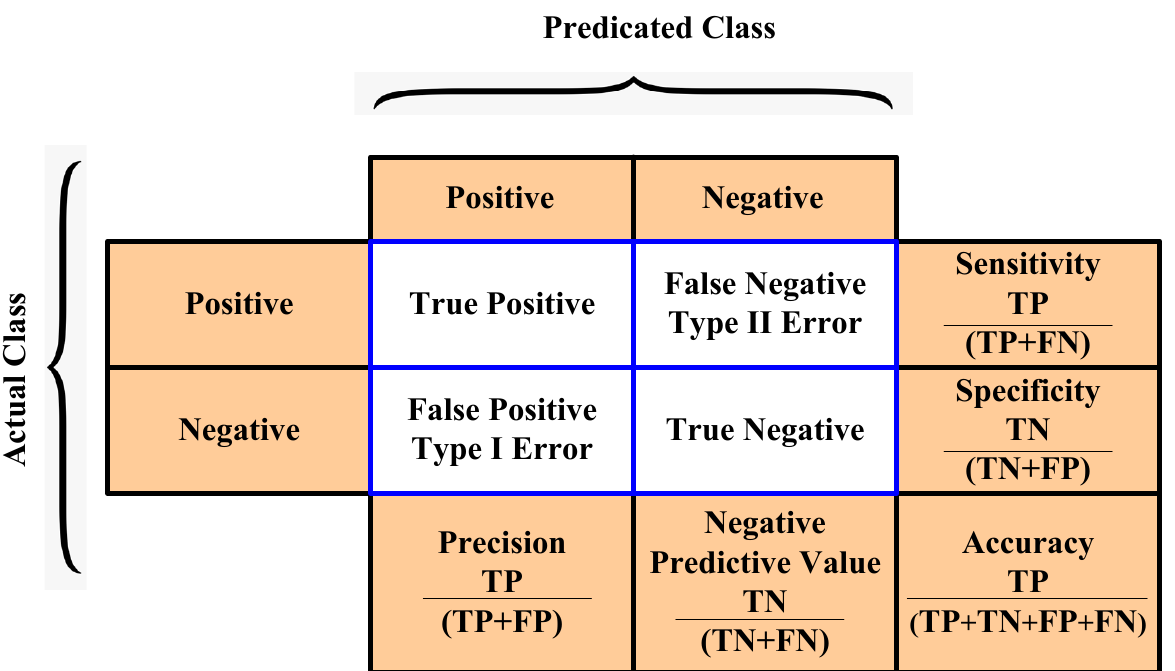
Figure 4. Confusion Matrix with Sensitivity, Specificity, Accuracy, and Precision value.